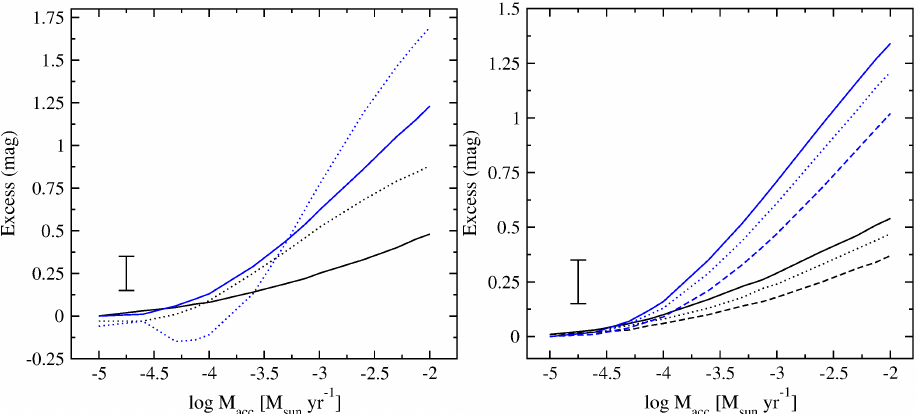
Figure 5. Predicted excesses as a function of the accretion rate from BL shock models for a typical HBe star with T ∗ = 12,500 K, M ∗ = 6 M (cid:12) , log g = 3, vsin i = 100 km s − 1 . The modeled Balmer excesses ( ∆ D B ) and UV excesses ( ∆ UV ) are in black and blue, respectively. Maximum observational errorbars corresponding to excesses based on broadband photometry are shown. Note the different scales in the y-axes. ( Left panel ) Solid and dotted lines indicate BL sizes given by δ 0 = 0.03 and 0.3, respectively. ( Right panel ) Different inclinations to the line of sight are shown with solid, dotted, and dashed lines indicating inclinations to the line of sight i = 30 ◦ , 45 ◦ and 60 ◦ ,